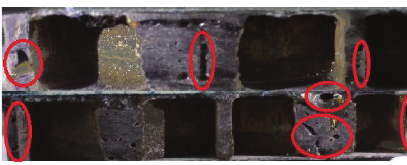
Figure 11: Fiber voids defect.